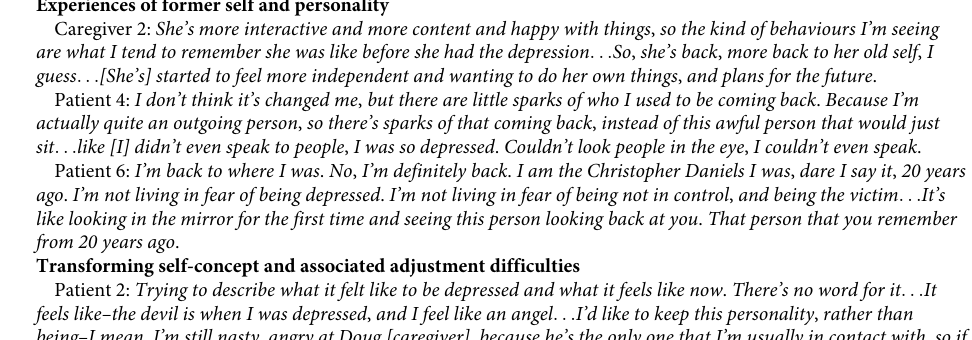
Table 2. Impact of mental illness and treatment on self-concept–Post-DBS. Experiences of former self and personality Caregiver 2: She’s more interactive and more content and happy with things , so the kind of behaviours I’m seeing are what I tend to remember she was like before she had the depression ... So , she’s back , more back to her old self , I guess ... [She’s] started to feel more independent and wanting to do her own things , and plans for the future . Patient 4: I don’t think it’s changed me , but there are little sparks of who I used to be coming back . Because I’m actually quite an outgoing person , so there’s sparks of that coming back , instead of this awful person that would just sit ... like [I] didn’t even speak to people , I was so depressed . Couldn’t look people in the eye , I couldn’t even speak . Patient 6: I’m back to where I was . No , I’m definitely back . I am the Christopher Daniels I was , dare I say it , 20 years ago . I’m not living in fear of being depressed . I’m not living in fear of being not in control , and being the victim ... It’s like looking in the mirror for the first time and seeing this person looking back at you . That person that you remember from 20 years ago . Transforming self-concept and associated adjustment difficulties Patient 2: Trying to describe what it felt like to be depressed and what it feels like now . There’s no word for it ... It feels like–the devil is when I was depressed , and I feel like an angel ... I’d like to keep this personality , rather than being–I mean , I’m still nasty , angry at Doug [caregiver] , because he’s the only one that I’m usually in contact with , so if I have to take anything out , I usually take it out on him . Caregiver 2: She’s doing all these things , she’s starting to feel better about herself , and she’s hoping people see that and acknowledge that , and not everyone does . Everyone’s involved in their own worlds as well , so she just has trouble expressing it , I guess . Caregiver 6: He’s different to how he was when he was grossly ill , but [he’s] more like the Christopher that I had , just a little bit more self-centred ... I think it’s been all about him for so long ... He has been ill a long time , and I assume it affects anybody , if you’ve been ill a long time ... It’s hard for him . Fundamentally unchanged, transient experiences Caregiver 3: I would say that there have been times where she’s told me that she doesn’t feel like herself , where she felt that she’s done things that were out of character for her ... There have been times where she has been experimenting with the DBS and those have led to the more manic episodes